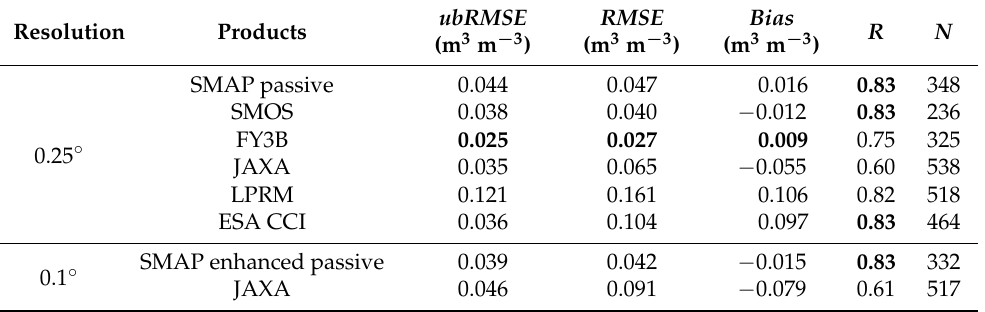
Table 2. Comparison of the SMAP passive, SMOS, FY3B, JAXA, and LPRM products at a spatial resolution of 0.25 ◦ , and the SMAP enhanced passive and JAXA AMSR2 products at a spatial resolution of 0.1 ◦ , with in-situ measurements, for the REMEDHUS network. The ubRMSE, RMSE, and bias are in m 3 m − 3 , R is the correlation coefficient ( p -value < 0.01), and N is the number of samples. Bold data in the table represent the best results concerning each error